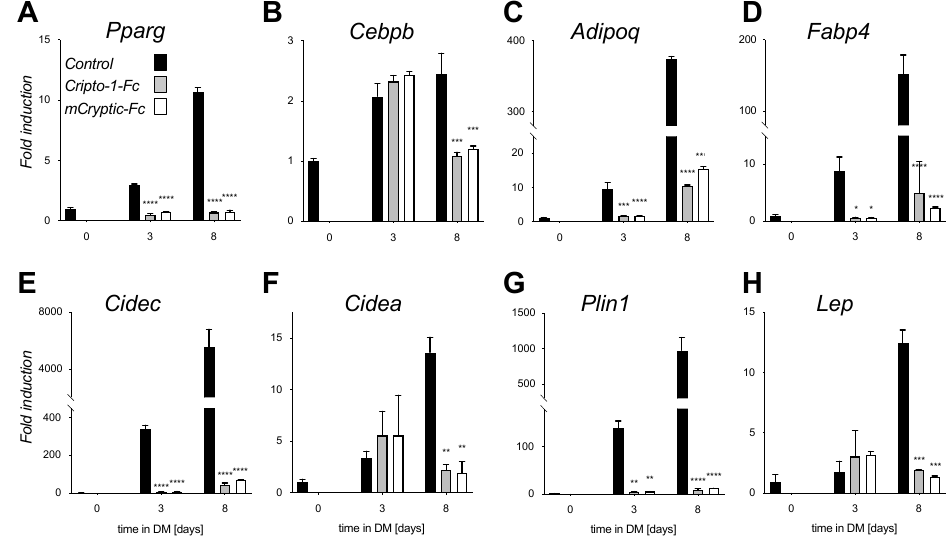
Figure 4. Inhibitory traps suppress expression of adipocyte marker genes. ( A – H ) Induction of adipocyte marker gene expression was analyzed by qRT- PCR on days 0, 3 and 8 of differentiation in control, mCryptic-Fc, and Cripto-1-Fc treated cells (black, grey and white bars, respectively). RNA isolation and qRT-PCR analysis were performed as described [42]. Data was normalized to Rpl4 mRNA and is shown as fold induction relative to day 0 levels. Statistical significance from two biological replicates was determined by two-way ANOVA and Sidaki’s post-hoc tests (* p < 0.05; ** p < 0.01; *** p < 0.001; **** p < 0.0001) using Prism 9. Expression of adipogenic transcription factors ( A ) Pparg, and ( B ) Cebpb. Expression of adipocyte marker genes ( C ) Adipoq, ( D ) Fabp4, and ( E ) Lep. Expression of genes associated with lipid droplet formation ( F ) Cidec, ( G ) Cidea, and ( H ) Plin1.